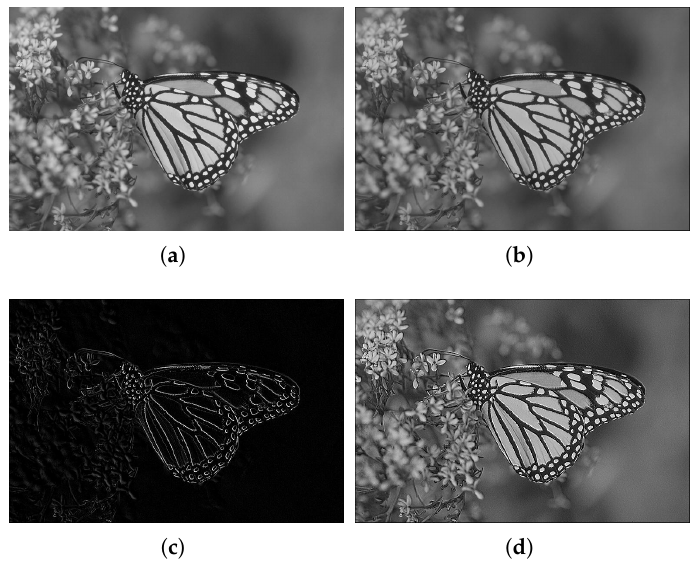
Figure 9. Example 2: results obtained using the three proposed stochastic computing CNN with different gene values. ( a ) Original image. ( b ) Stored image. ( c ) Edge detection result. ( d ) Sharp- ened